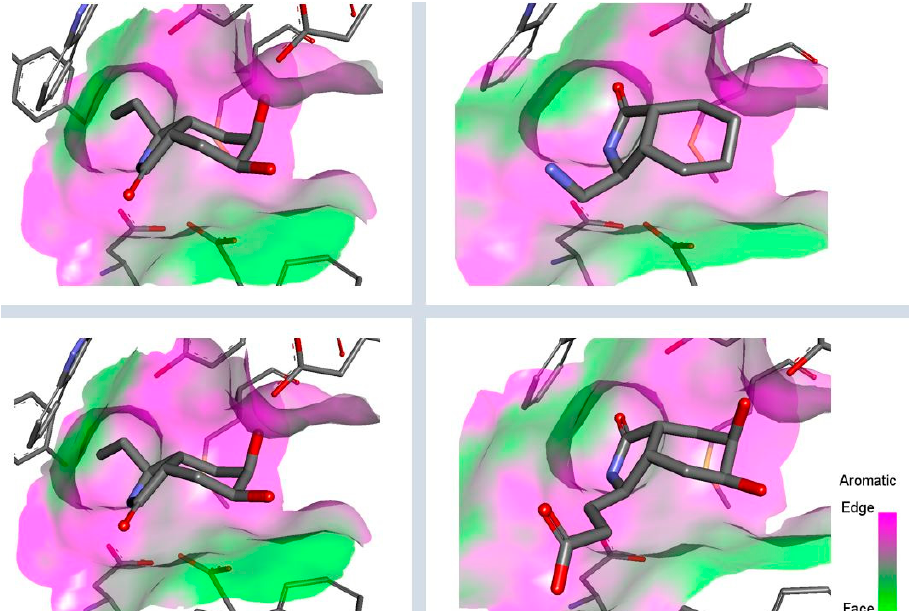
Figure 10. Scaffold modifications A , ent - A , C , and ent - C in the C-3 position for group I and II. Surface plot of the catalytic site, showing the aromatic interaction profile. Group I (R = − (CH 2 )n − Z, n = 1 to 3, Z = functional group) and group I (R = − (CH 2 )n-CH 3 , n = 1 to 6). The face label indicates a face interaction between amino acid residues and ligands’ hydrophobic fragments, and the edge label shows the noncoplanar amino acid residues orientation to the protein surface.